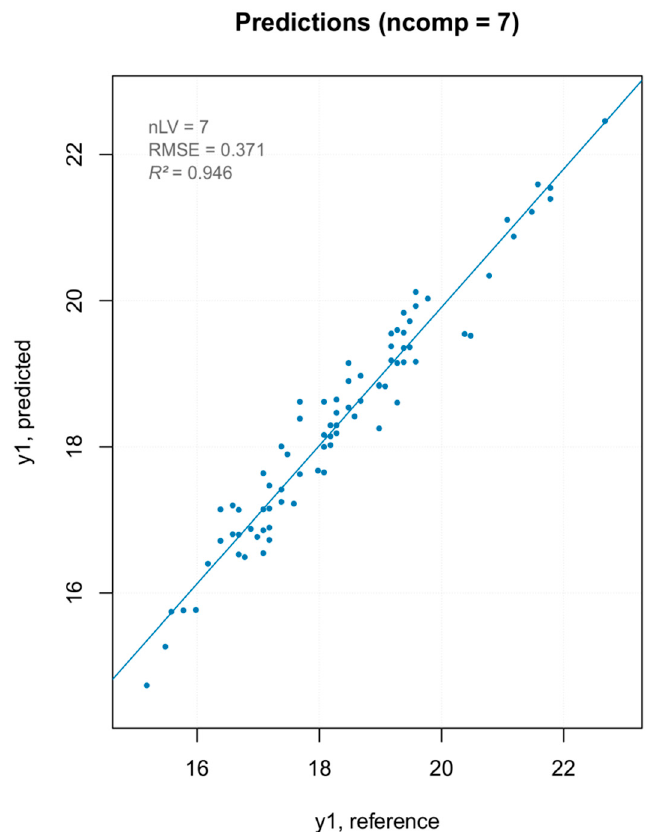
Figure 16. Prediction plot for the final TSS